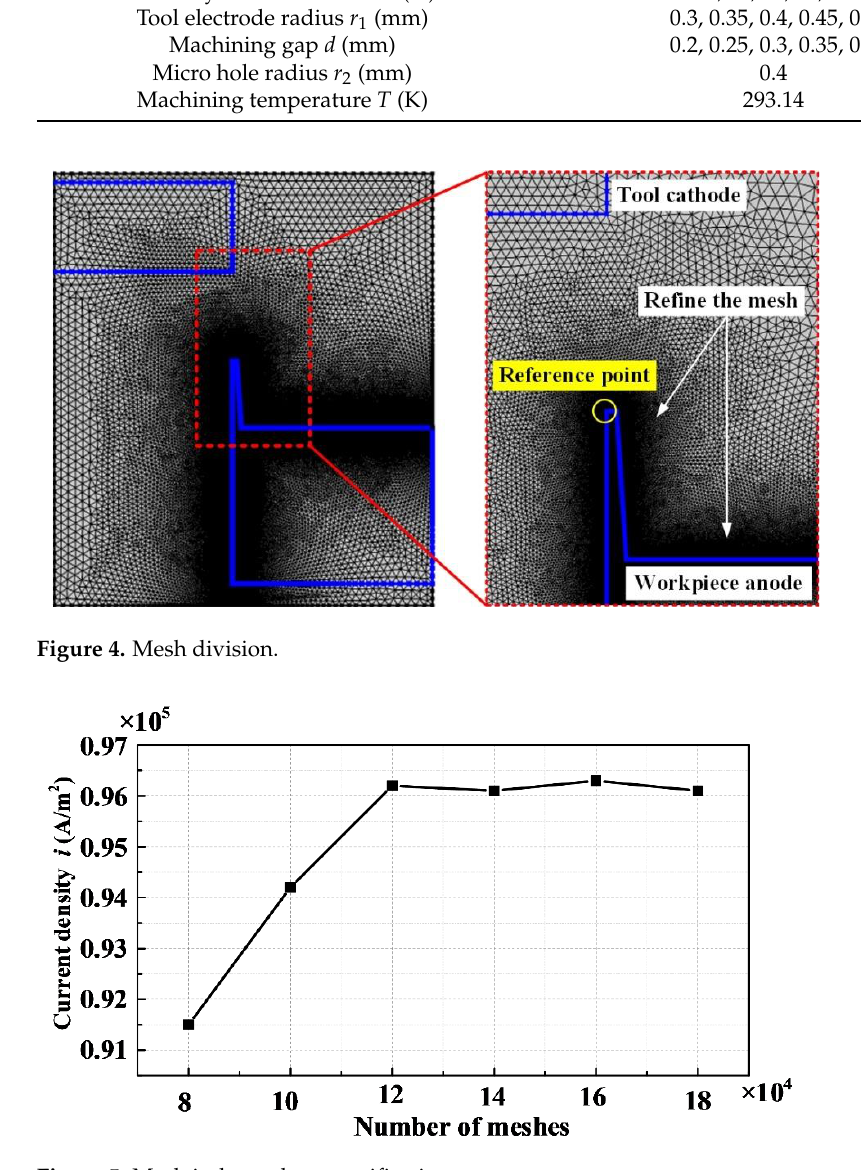
Figure 5. Mesh independence